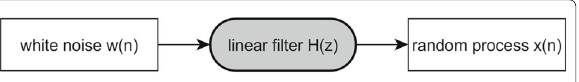
Fig. 5 Generation of stationary random process by filtering input white